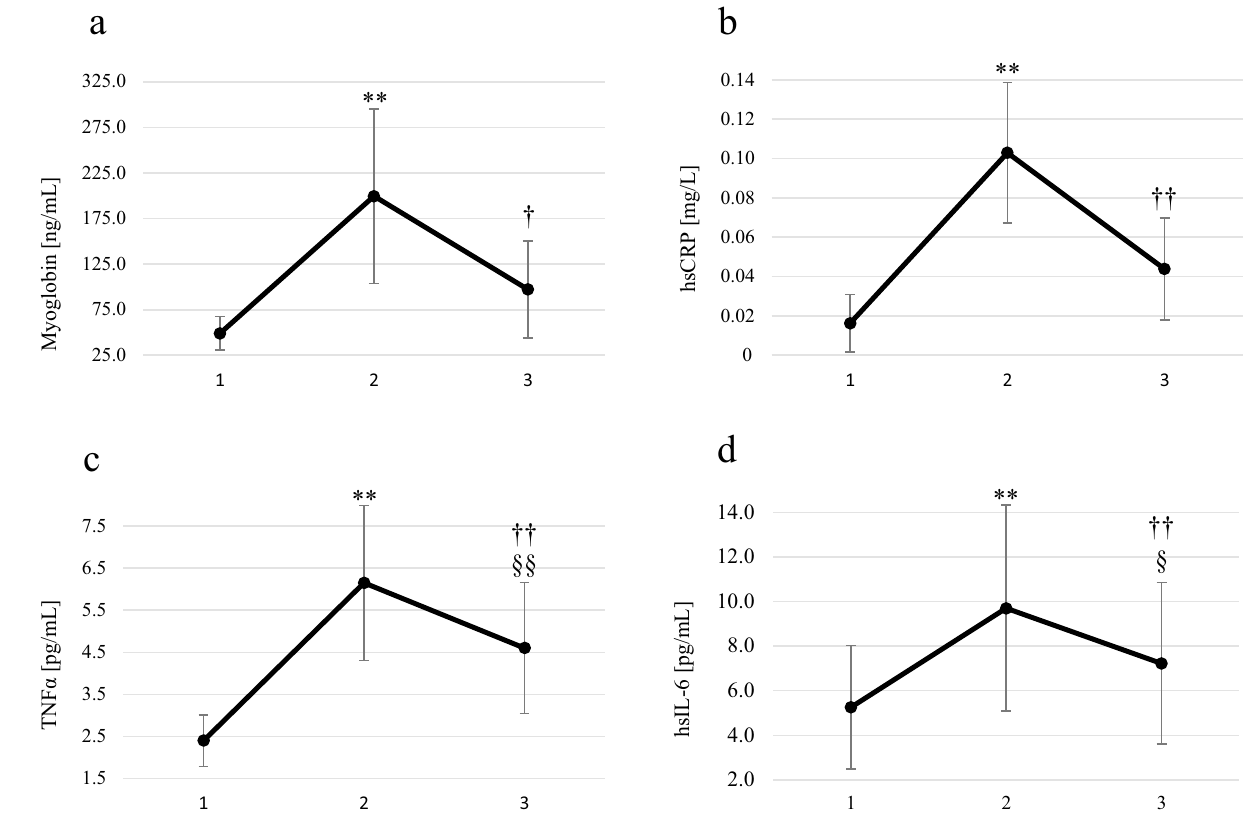
Figure 2. Blood concentrations of myoglobin, hsCRP, TNFα, and hsIL-6 in male amateur runners before and after the Visegrad Marathon. ( a ) myoglobin, ( b ) hsCRP, ( c ) TNFα, ( d ) hsIL-6. 1: before marathon; 2: 24 h after the marathon; 3: 72 h after the marathon. ** p < 0.01 significant differences between measurements before and 24 h after the marathon. †† p < 0.01 significant differences between measurements 24 h and 72 h after the marathon. † p < 0.05 significant differences between measurements 24 h and 72 h after the marathon. §§ p < 0.01 significant differences between measurements before and 72 h after the marathon. § p < 0.05 significant differences between measurements before and 72 h after the